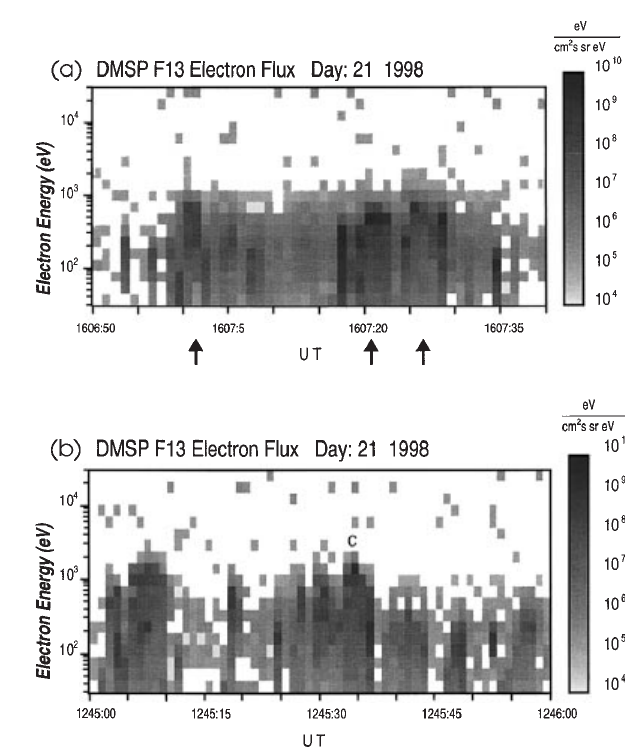
Fig. 7. Plots of Eureka MSP scans similar to Fig. 6, but from 1600 to 1616 UT on